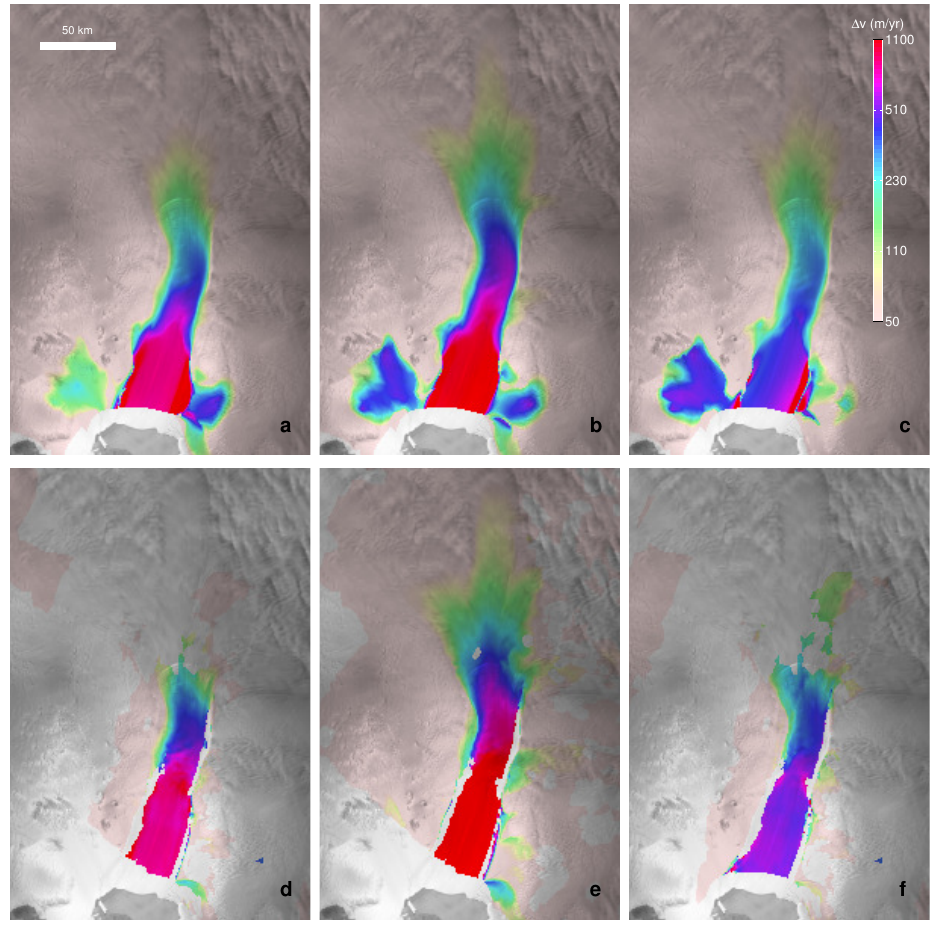
Figure 7. Changes in observed and modeled velocities in myr − 1 on a logarithmic scale. (a) Modeled year 11–year 1, (b) modeled year 15–year 1, (c) modeled year 15–year 11, (d) , observed 2006–1996, (e) observed 2010–1996, (f) observed 2011–2006. Modeled velocities are from the increased basal melting experiment (melting multiplied by